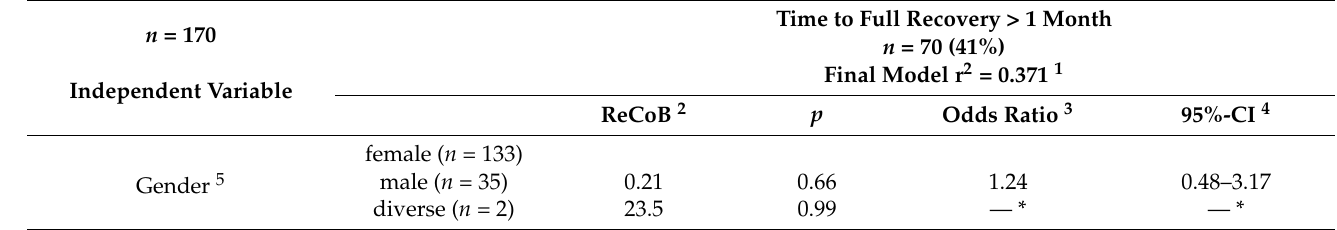
Table A1. Factors influencing the time to self-perceived full